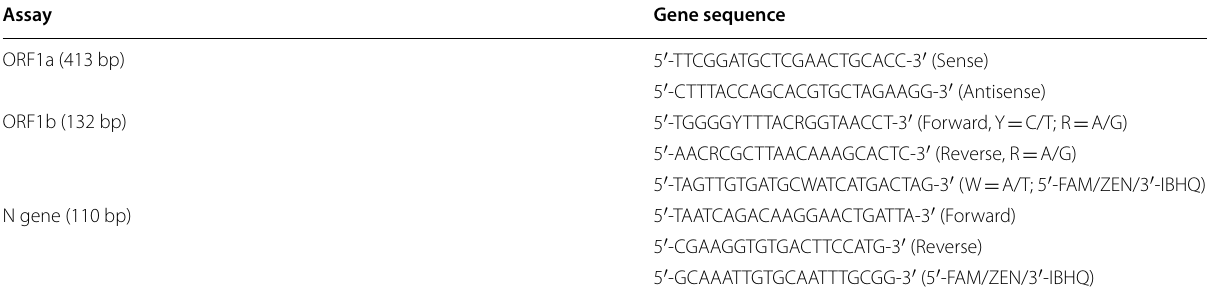
Table 2 Primers and probes sequences used in RT-PCR [59] Assay Gene sequence ORF1a (413